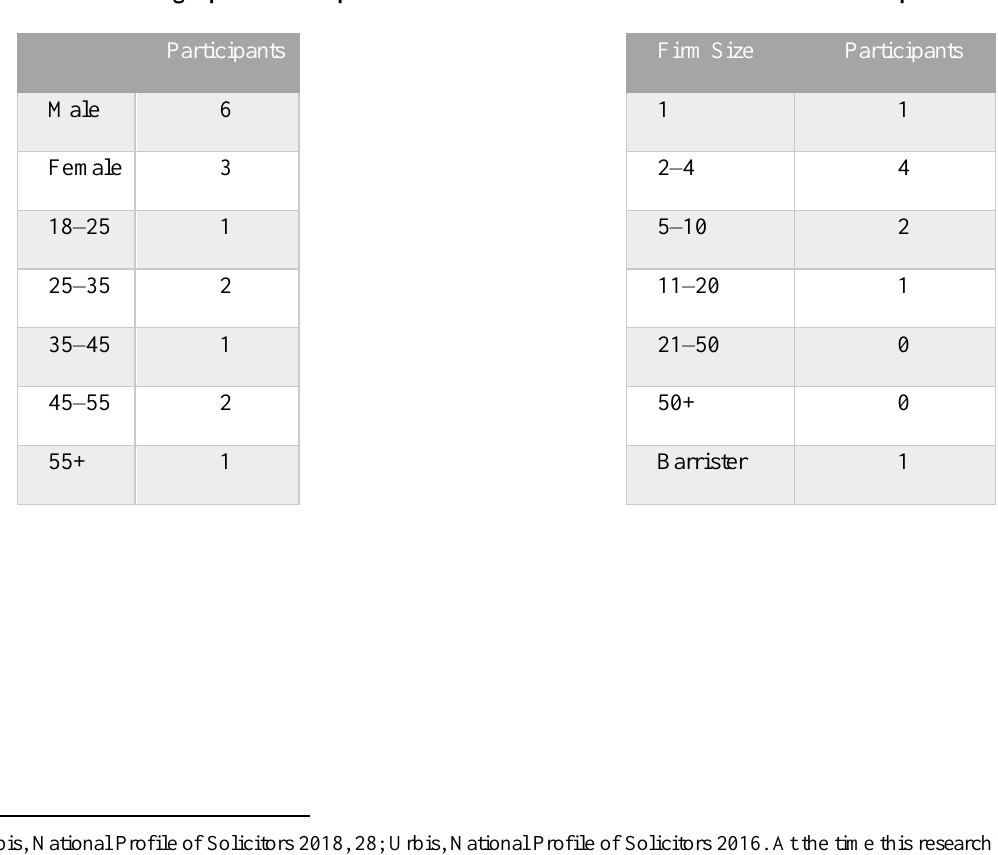
Table 2: Firm-Size of